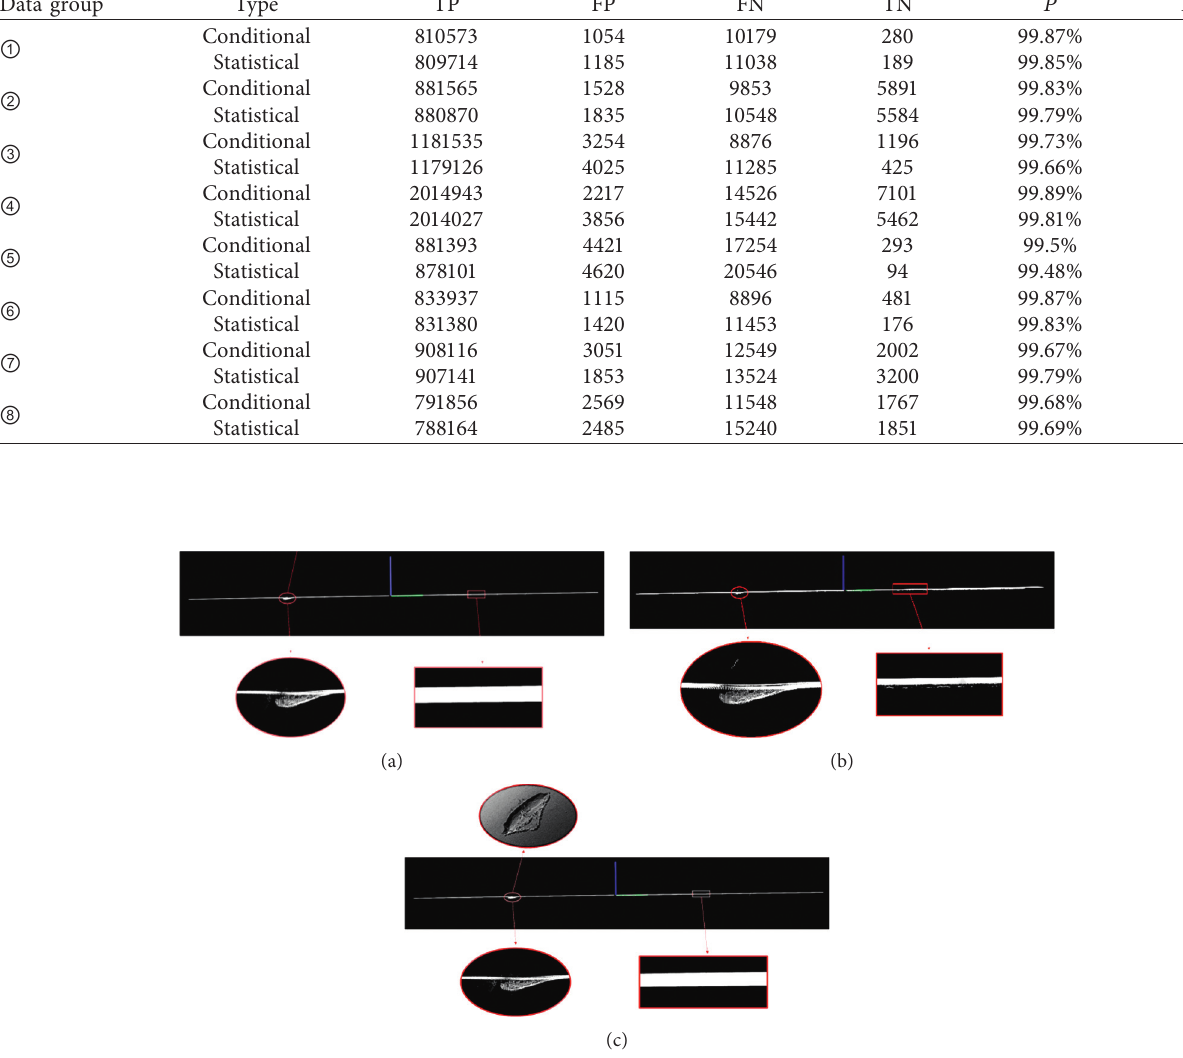
Table 2: Calculation of precision rate P and recall rate R by using conditional denoising or statistical denoising. Data group